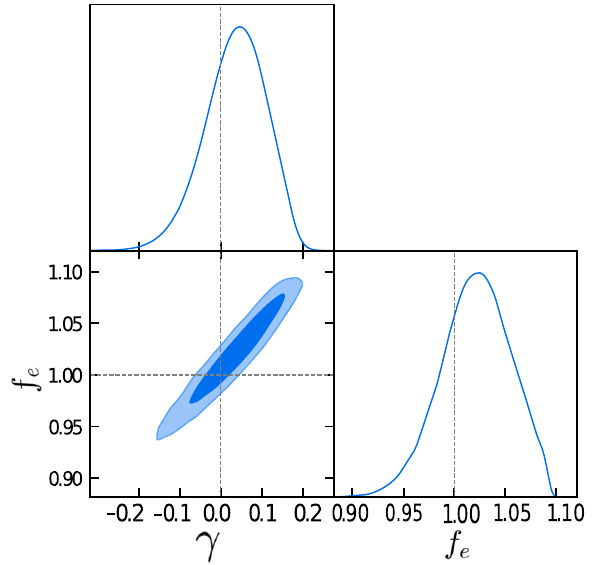
Fig. 3 Posteriori probability distribution of free parameters γ and ϒ for the PLAW model considering σ int ≈ 12 . 22%. The vertical dashed lines correspond to no variation of α . As one may see, the PLAW model agrees to the SIS model within 1 σ